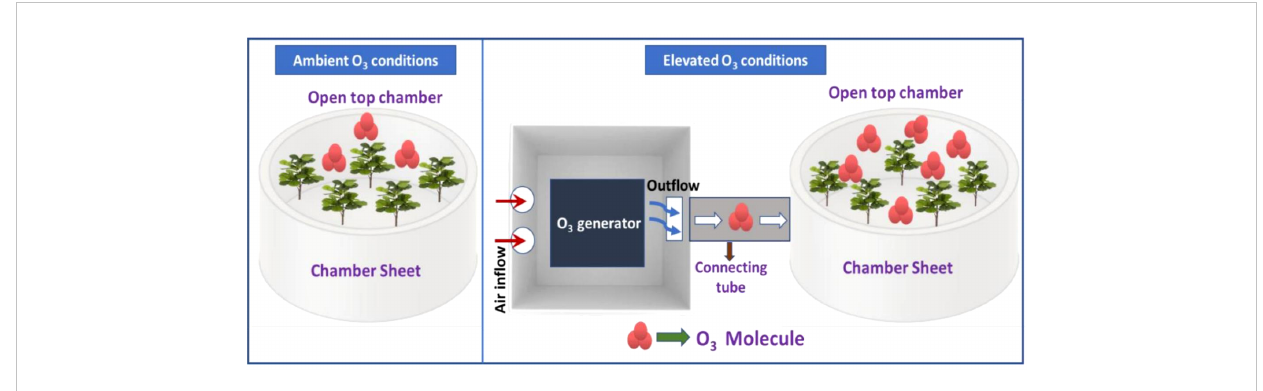
FIGURE 1 Diagrammatic representation of experimental